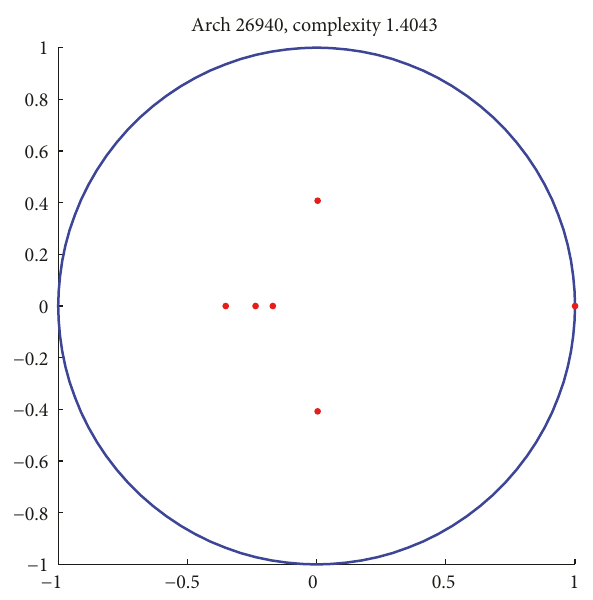
Figure 9: Eigenvalues for high complexity